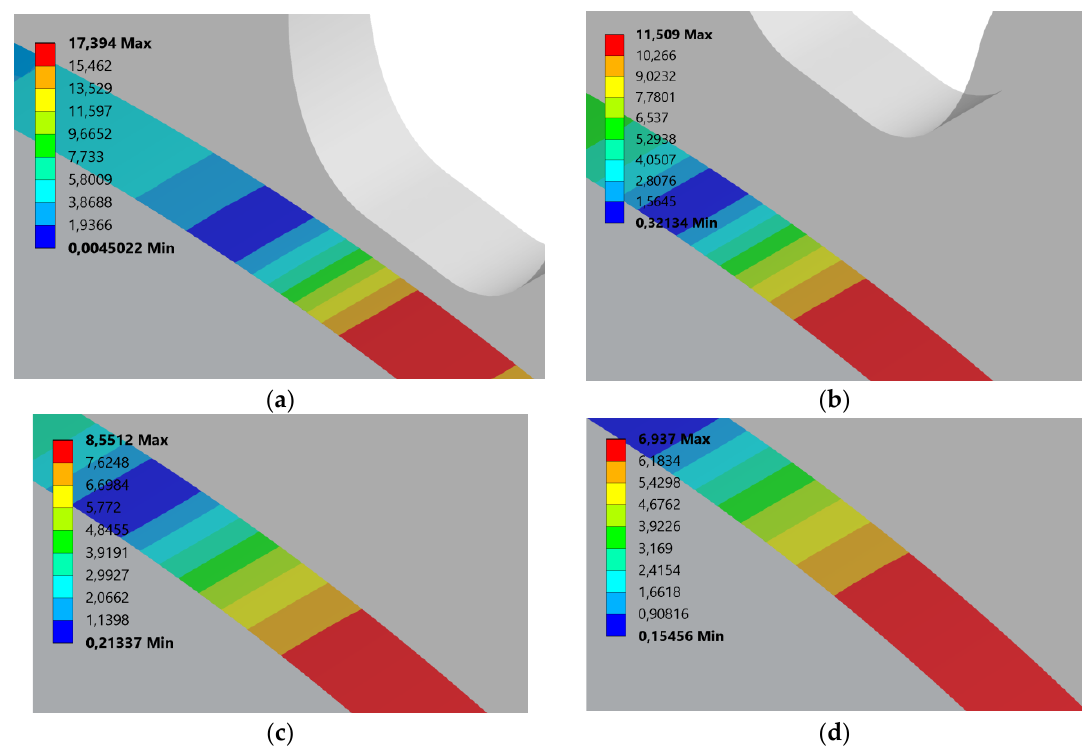
Figure 15. Shear stress results for hybrid gears generated rack tip radius, ρ 1 = 0.2 xm for different